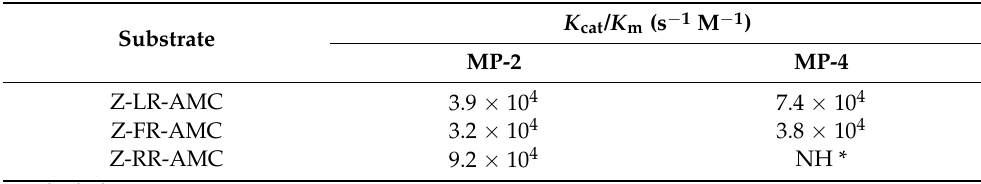
Figure 4. Biochemical properties of recombinant MP-2 and MP-4. ( a ) Hydrolysis of dipeptidyl substrates. Activity of each enzyme against each substrate was assayed in 100 mM sodium acetate (pH 4.0–5.5), sodium phosphate (6.0–6.5), or Tris-HCl (pH 7.0–7.5) supplemented with 10 mM DTT. Maximal activity was presented as 100%. ( b ) Enzyme stability. Each enzyme was incubated in different pH buffers for the indicated time, and the residual enzyme activity was assayed. For MP-2, Z-RR-MCA was used as a substrate. Meanwhile, Z-LR-MCA was used as a substrate for MP-4. ( c ) Effect of reducing agents. Activity of each enzyme was assayed in 100 mM sodium acetate buffer (pH 5.0) in the presence or absence of different concentrations of DTT or GSH. Enzyme activity was assayed with Z-RR-MCA and Z-LR-MCA for MP-2 and MP-4, respectively. Table 2. Kinetics of MP-2 and MP-4.